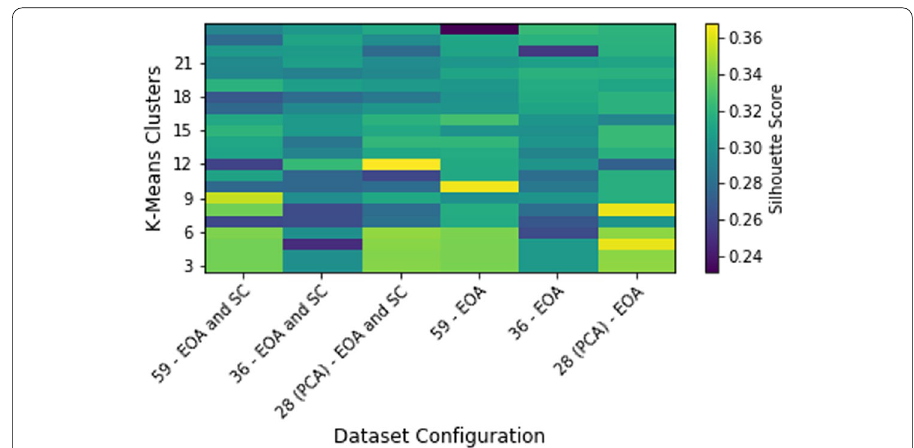
Fig. 10 Silhouette scores of clusters identified by K-Means where k ∈ [ 3,24 ] for different dataset configurations